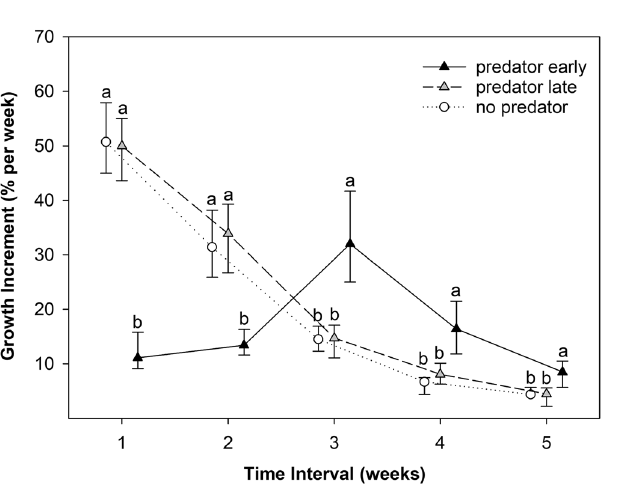
Figure 2. Size at metamorphosis and time to metamorphosis of individual tadpoles in the treatments. Note that some dots overlap.